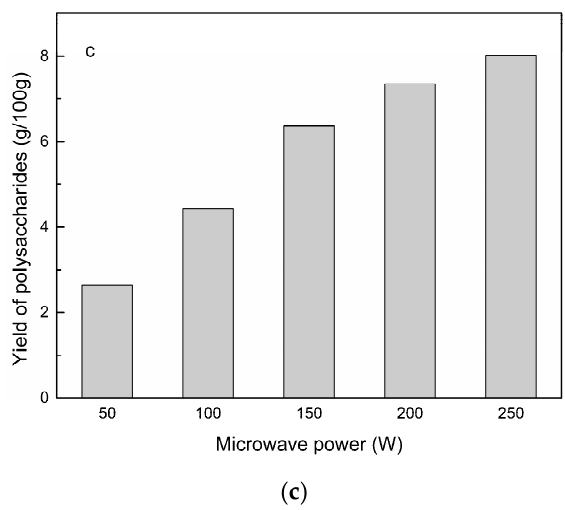
Figure 3. Single factor analysis of polysaccharide extraction. Effect of extraction parameters on polysaccharide yield: ( a ) Solid-liquid ratio, ( b ) ultrasound power, and ( c ) microwave power.